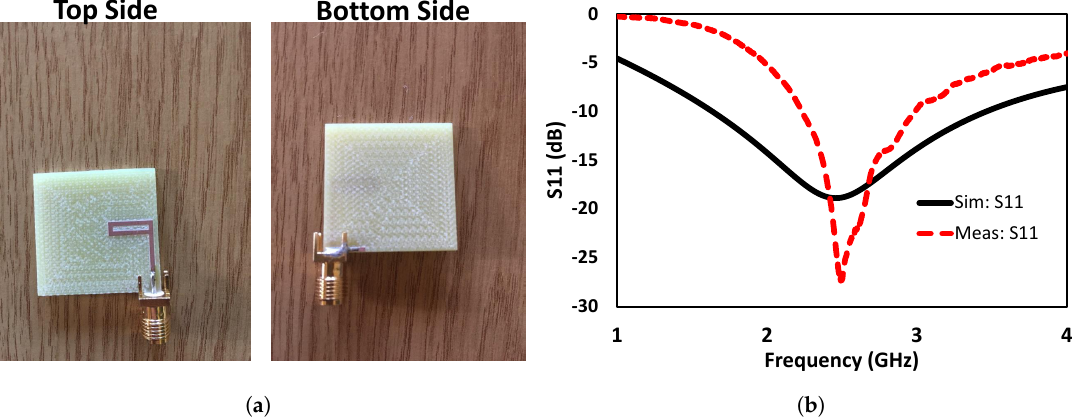
Figure 2. ( a ) Fabricated prototype of single-element antenna, and ( b ) simulated and measured reflection coefficient of the single-element antenna. Table 2. The dimensions of the proposed MIMO